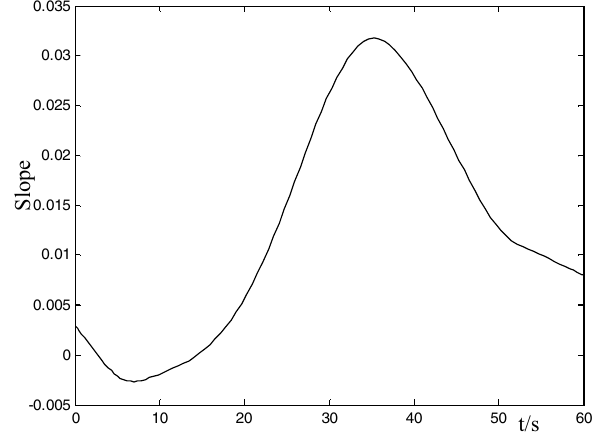
Fig. 13 Time history curve of vertical displacement for all pontoons (abbreviated as Pon.)